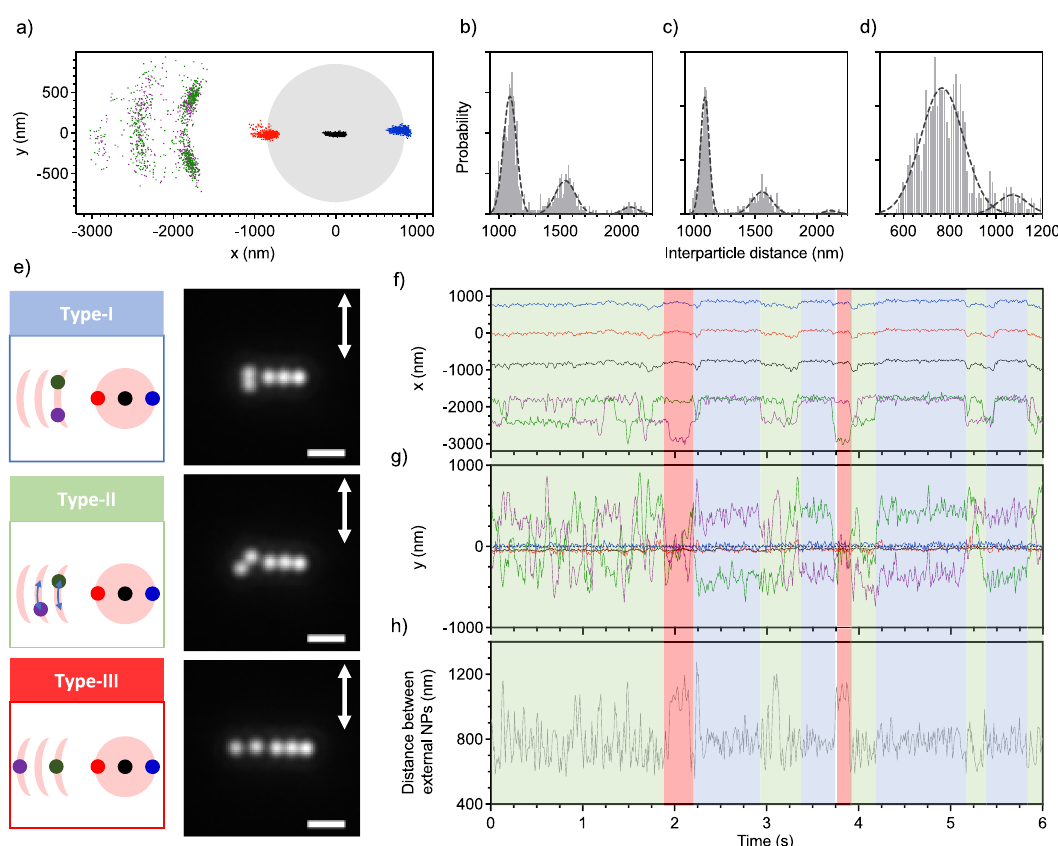
Fig. 4 | Spatial distributions for the fi ve trapped Au NPs system. ( a ) The two- dimensional distribution in the x,y-focal plane, shadowed grey circle corresponds to the estimated diameter of laser focus (1.8 µ m). b – d Interparticle distance dis- tribution between ( b ) purple and red-marked NPs, ( c ) green and red marked NPs, and ( d ) green and purple marked NPs. The dashed lines are the Gaussian fi tting curves which mean value approximately corresponds to 1.5, 2 and 2.5 λ * separa- tions. e Illustrations and representative images for Type-I, Type-II and Type-III